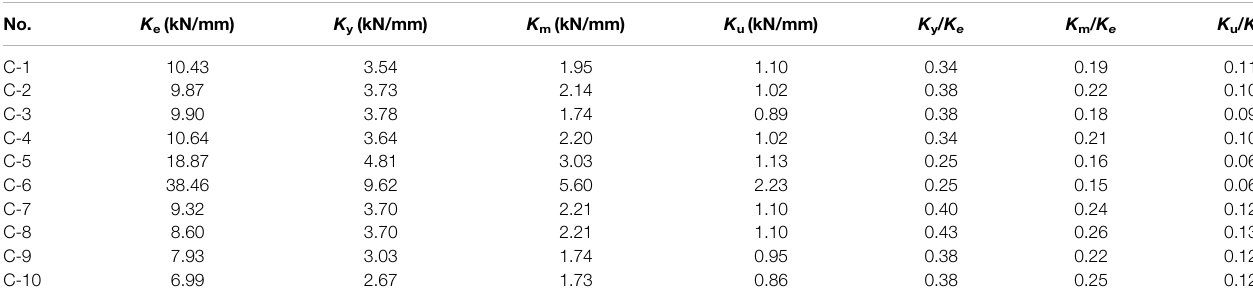
TABLE 8 | Measured stiffness at characteristic